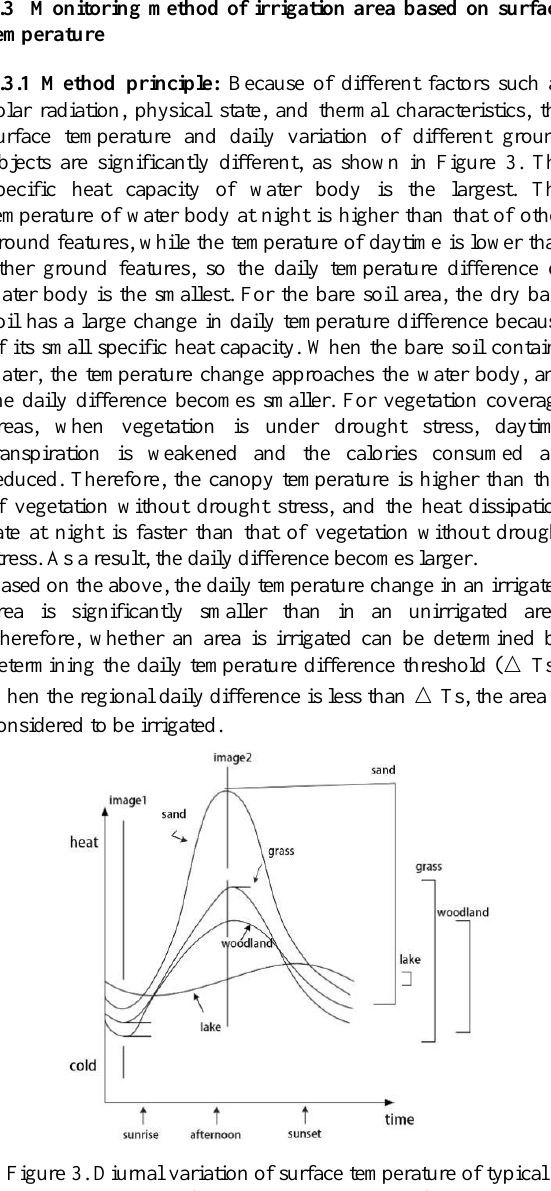
Figure 3. Diurnal variation of surface temperature of typical terrain (Yingshi Zhao et al., 2003)